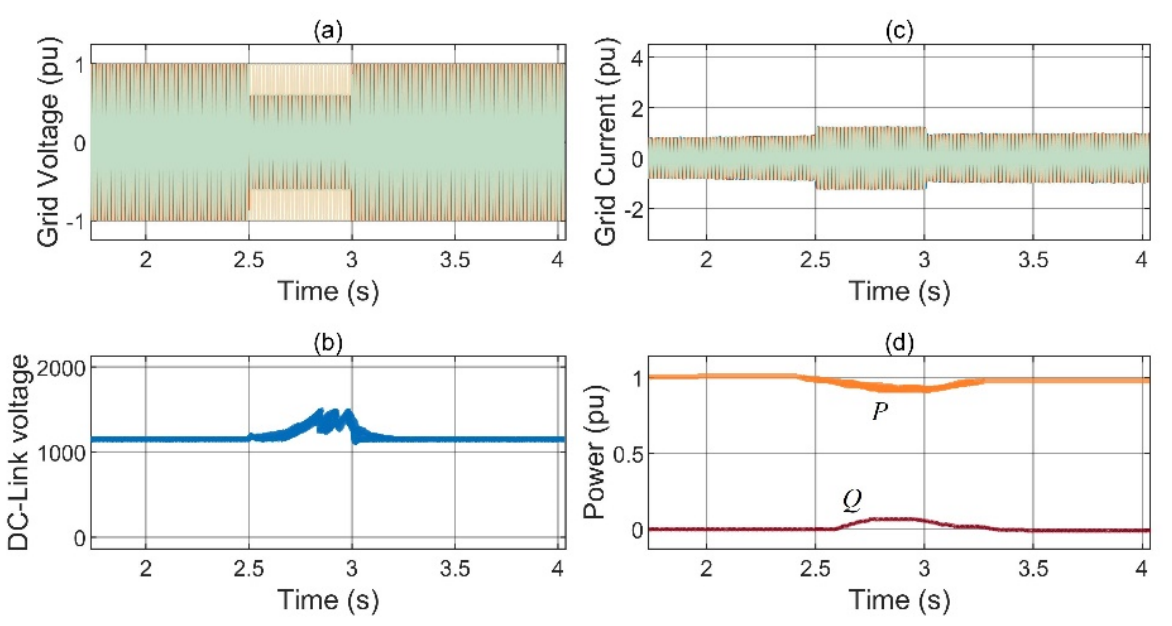
Figure 16. LVRT Performance of PI controller during asymmetrical grid fault. ( a ) Grid voltage ( b ) Inverter current ( c ) DC-link voltage ( d ) Active and Reactive power.